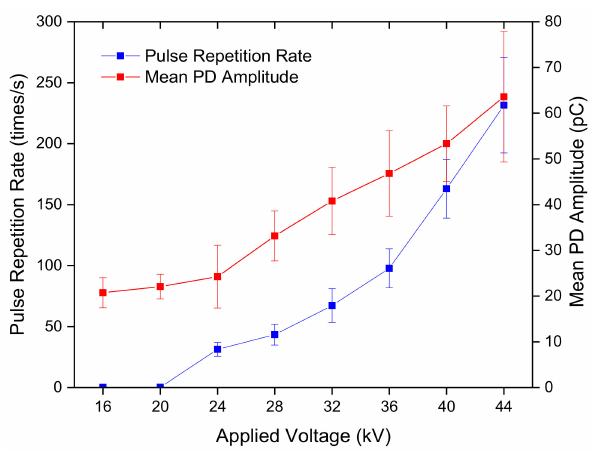
Figure 7. PD parameters under AC/DC proportion of 1:3.